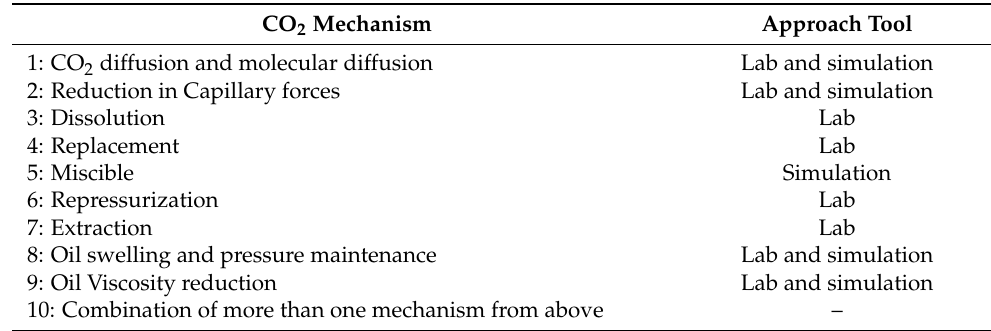
Table 5. The mechanism of CO 2 -EOR in unconventional reservoirs (Modified on the basis of Alfarge et al. [34] and Lang D. et al.